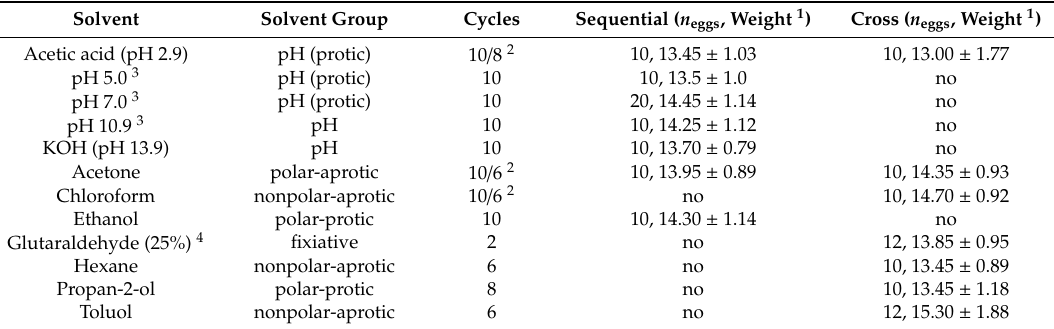
Table 1. List of the used solutions, including specifications of eggs and experimental cycles. Solvent Solvent Group Cycles Sequential ( n eggs , Weight 1 ) Cross ( n eggs , Weight 1 ) Acetic acid (pH 2.9) pH (protic) 10 / 8 2 10, 13.45 ± 1.03 10, 13.00 ± 1.77 pH 5.0 3 pH (protic) 10 10, 13.5 ± 1.0 no pH 7.0 3 pH (protic) 10 20, 14.45 ± 1.14 no pH 10.9 3 pH 10 10, 14.25 ± 1.12 no KOH (pH 13.9) pH 10 10, 13.70 ± 0.79 no Acetone polar-aprotic 10 / 6 2 10, 13.95 ± 0.89 10, 14.35 ± 0.93 Chloroform nonpolar-aprotic 10 / 6 2 no 10, 14.70 ± 0.92 Ethanol polar-protic 10 10, 14.30 ± 1.14 no Glutaraldehyde (25%) 4 fixiative 2 no 12, 13.85 ± 0.95 Hexane nonpolar-aprotic 6 no 10, 13.45 ± 0.89 Propan-2-ol polar-protic 8 no 10, 13.45 ± 1.18 Toluol nonpolar-aprotic 6